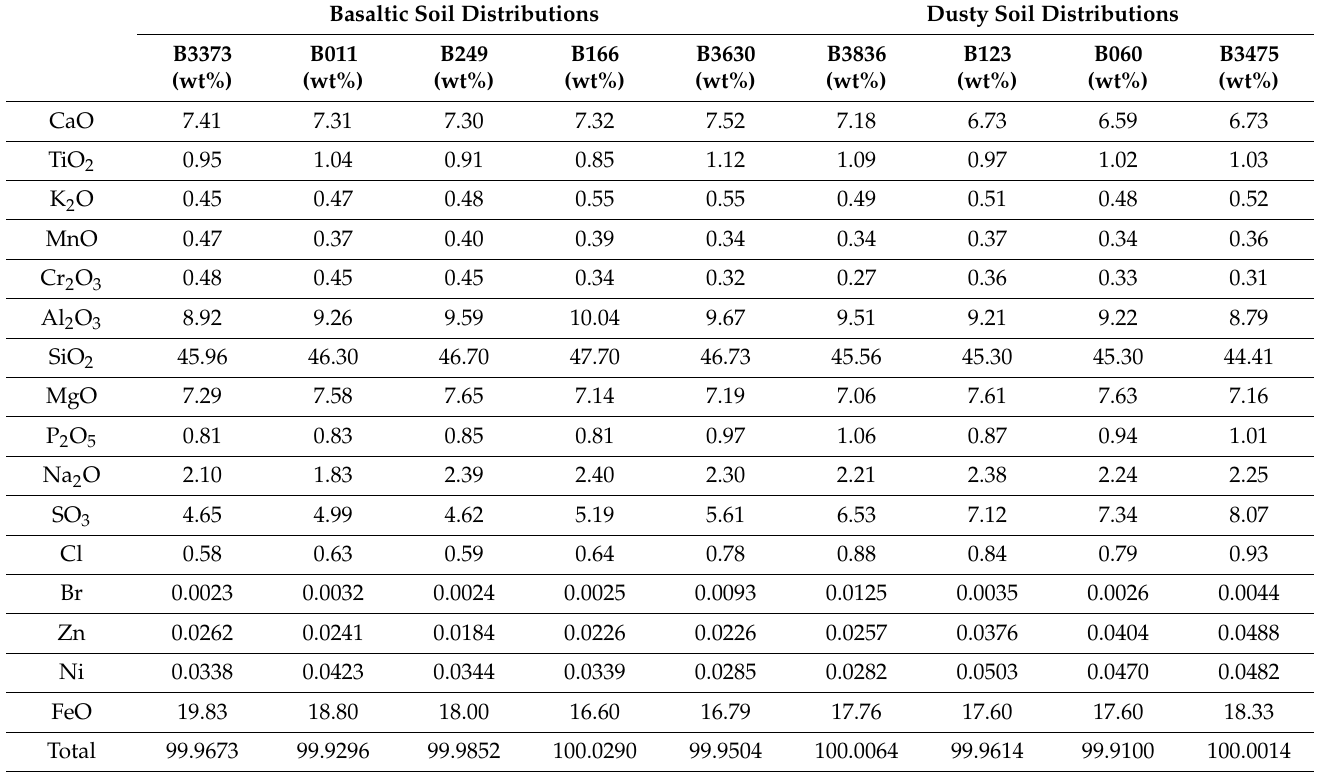
Table 3. Weight percentages of the distributions measured from basaltic and dusty soil targets. Basaltic Soil